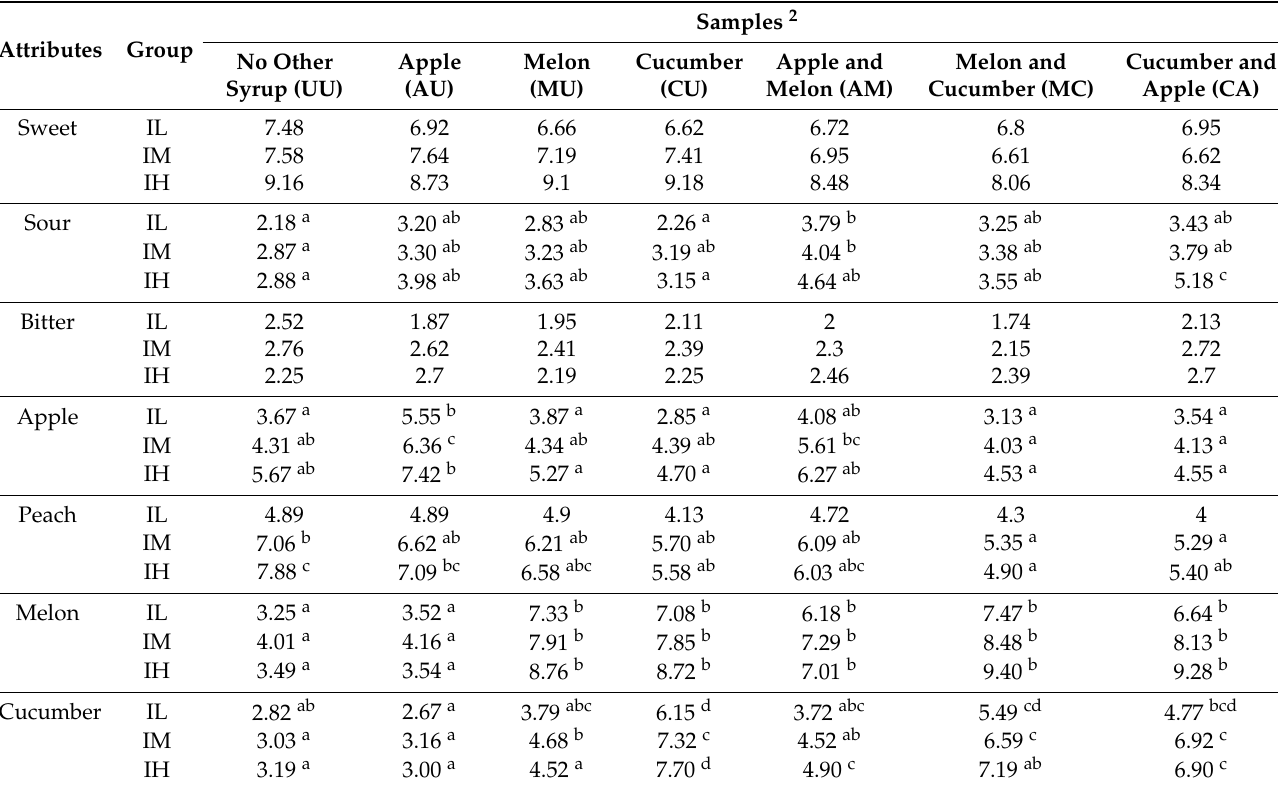
Figure 3. Principal Component Analysis (PCA) biplot of the samples (filled circles) and the sensory attributes (dotted line) for the first two PC dimensions: ( a ) IL; ( b ) IM; ( c ) IH. See Table 1 for sample codes. Only the attributes showing significant differences among the samples ( p < 0.05) are presented. Table 3. Mean intensity scores for sensory attributes 1 of the samples in low involvement (IL), moderate involvement (IM) and high involvement (IH) groups.